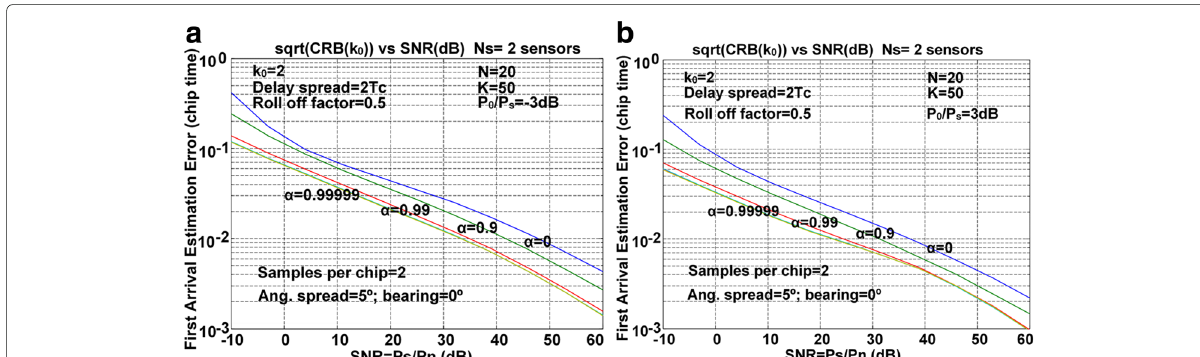
Fig. 8 CRB of the first arriving path k 0 as a function of dispersed SNR. Results are provided for different values of the temporal correlation coefficient α and for different values of the LOS component power. Two sensors and 50 channel vector estimates are available. The sampling rate set to twice the chip rate and a roll-off factor of 0.5. Delay spread set to 2 T c and angular spread set to 5°. Bearing direction is the broadside. a Left: LOS power set 3 dB lower than the dispersed signal power. b Right: LOS power set 3 dB higher than the dispersed signal power